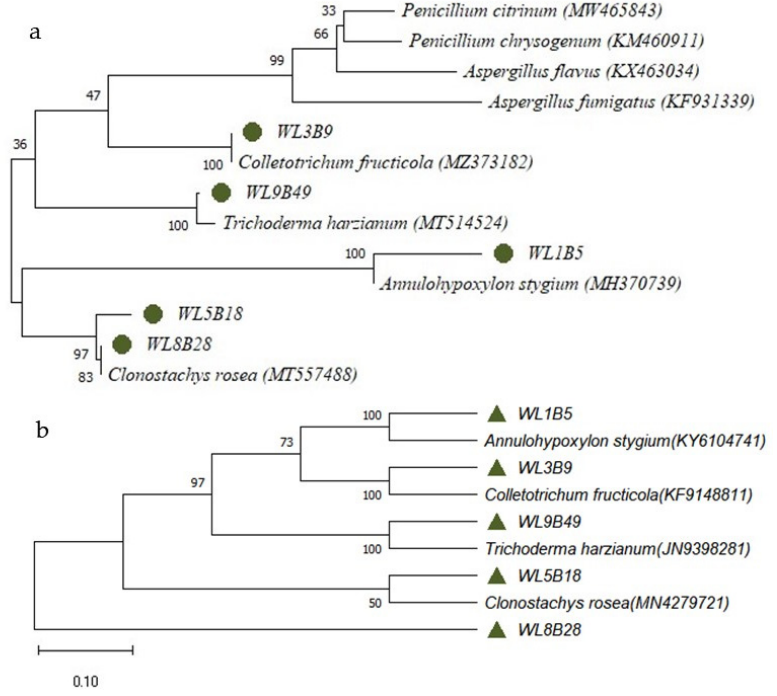
Figure 1. Phylogenetic tree constructed based on the sequences of ITS1-5.8S rRNA gene-ITS2 ( a ) and the D1/D2 domain of the 28S rRNA gene ( b ) using the maximum likelihood method and the Tamura-Nei model [8]. The percentage of trees in which the associated taxa clustered together in the bootstrap test (1000 replicates) is shown next to the branches. The tree is drawn to scale, with branch lengths indicating the number of substitutions per site. This analysis involved 22 nucleotide sequences. The green dots/pyramids indicate the isolates from this study. The others are previously identified sequences of antimicrobial substance-producing fungi. There were a total of 1318 positions in the final dataset. Evolutionary analyses were conducted by applying MEGA X v10.2.4.